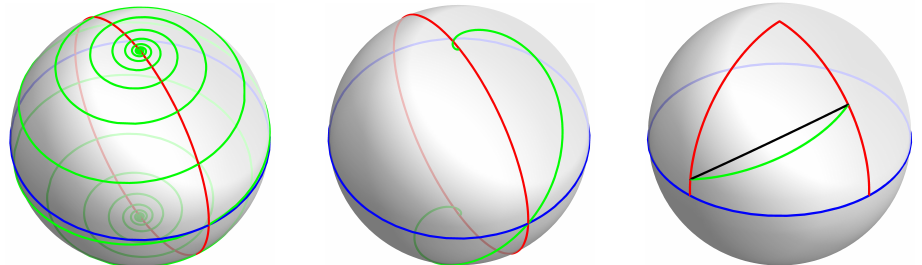
Figure 3. Loxodromes (green lines) of the azimuths α = 15 π /32 (left), α = π /4 (middle) on the λ -sphere with the deformation parameter λ geoid = 0.003348595 together with the meridians (red lines) and the Equator (blue lines). On the right, the comparison between the loxodrome and geodesic solving the corresponding inverse problems is shown when u 1 = 0.99, u 2 = 0.75, v 1 = 5 ◦ , v 2 = 85 ◦